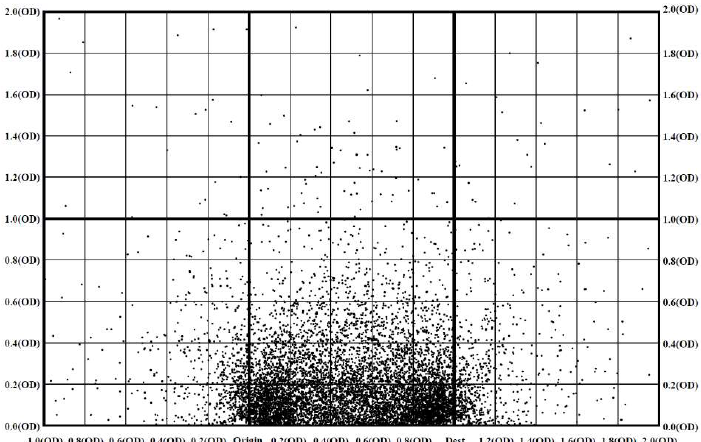
Figure 5. Grid structure on the transformed transfer location map.